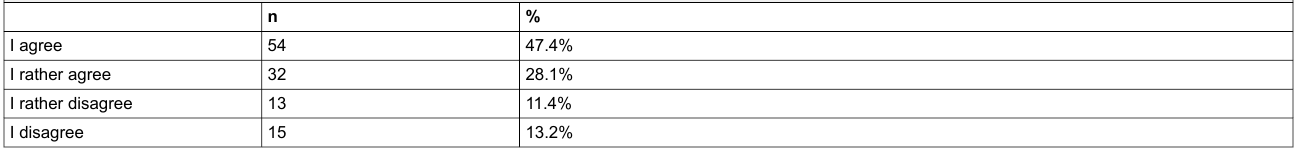
Table 3: Gender differences in attitudes to dietary supplements. Female Male p-value Searched for potential risks (n = 118) 21 (28%) <0.001 Turned to health professionals to get information (n =